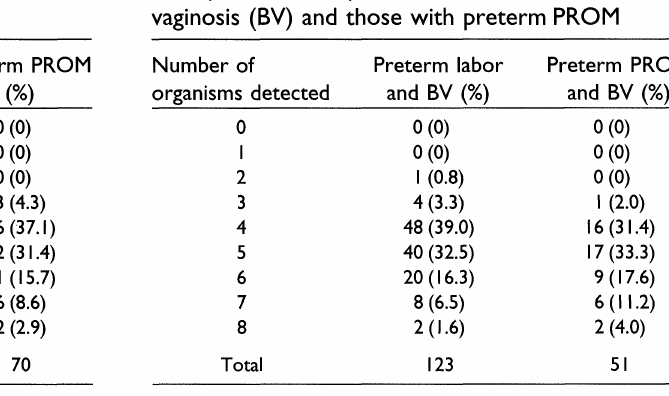
Table 3. The dominant organisms detected were Staphylococcus haemolyticus, Streptococcus agalactiae, Escherichia coli, Fusobacterium nucleatum, and